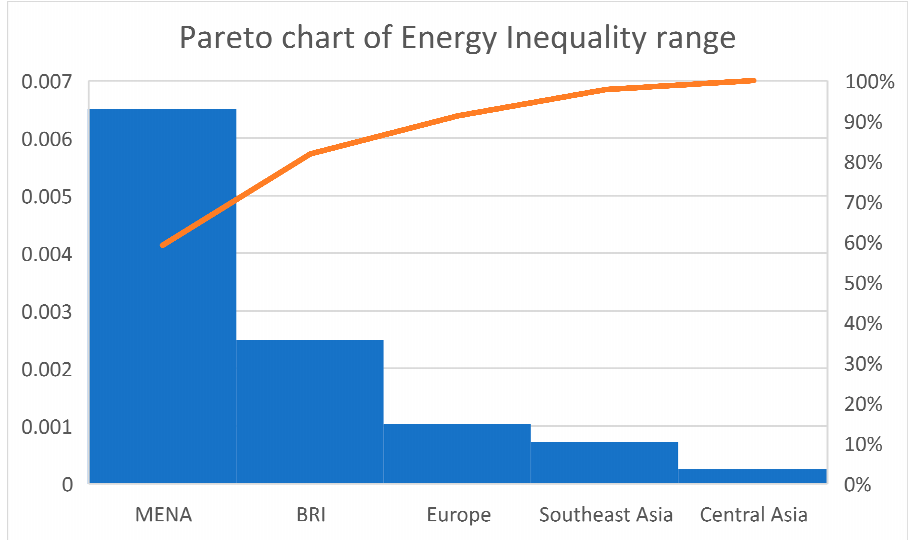
Figure 4. Pareto analysis.